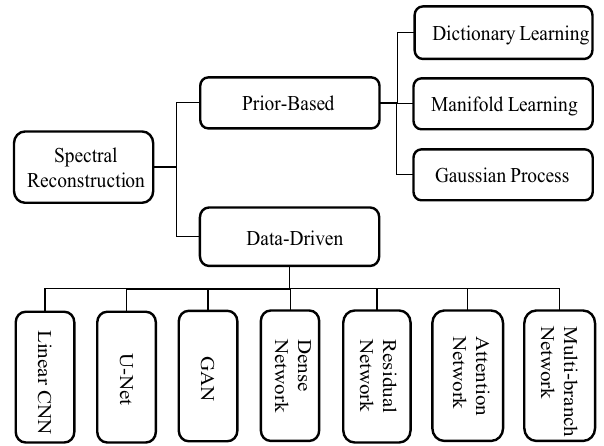
Figure 2. Classification of state-of-the-art spectral reconstruction